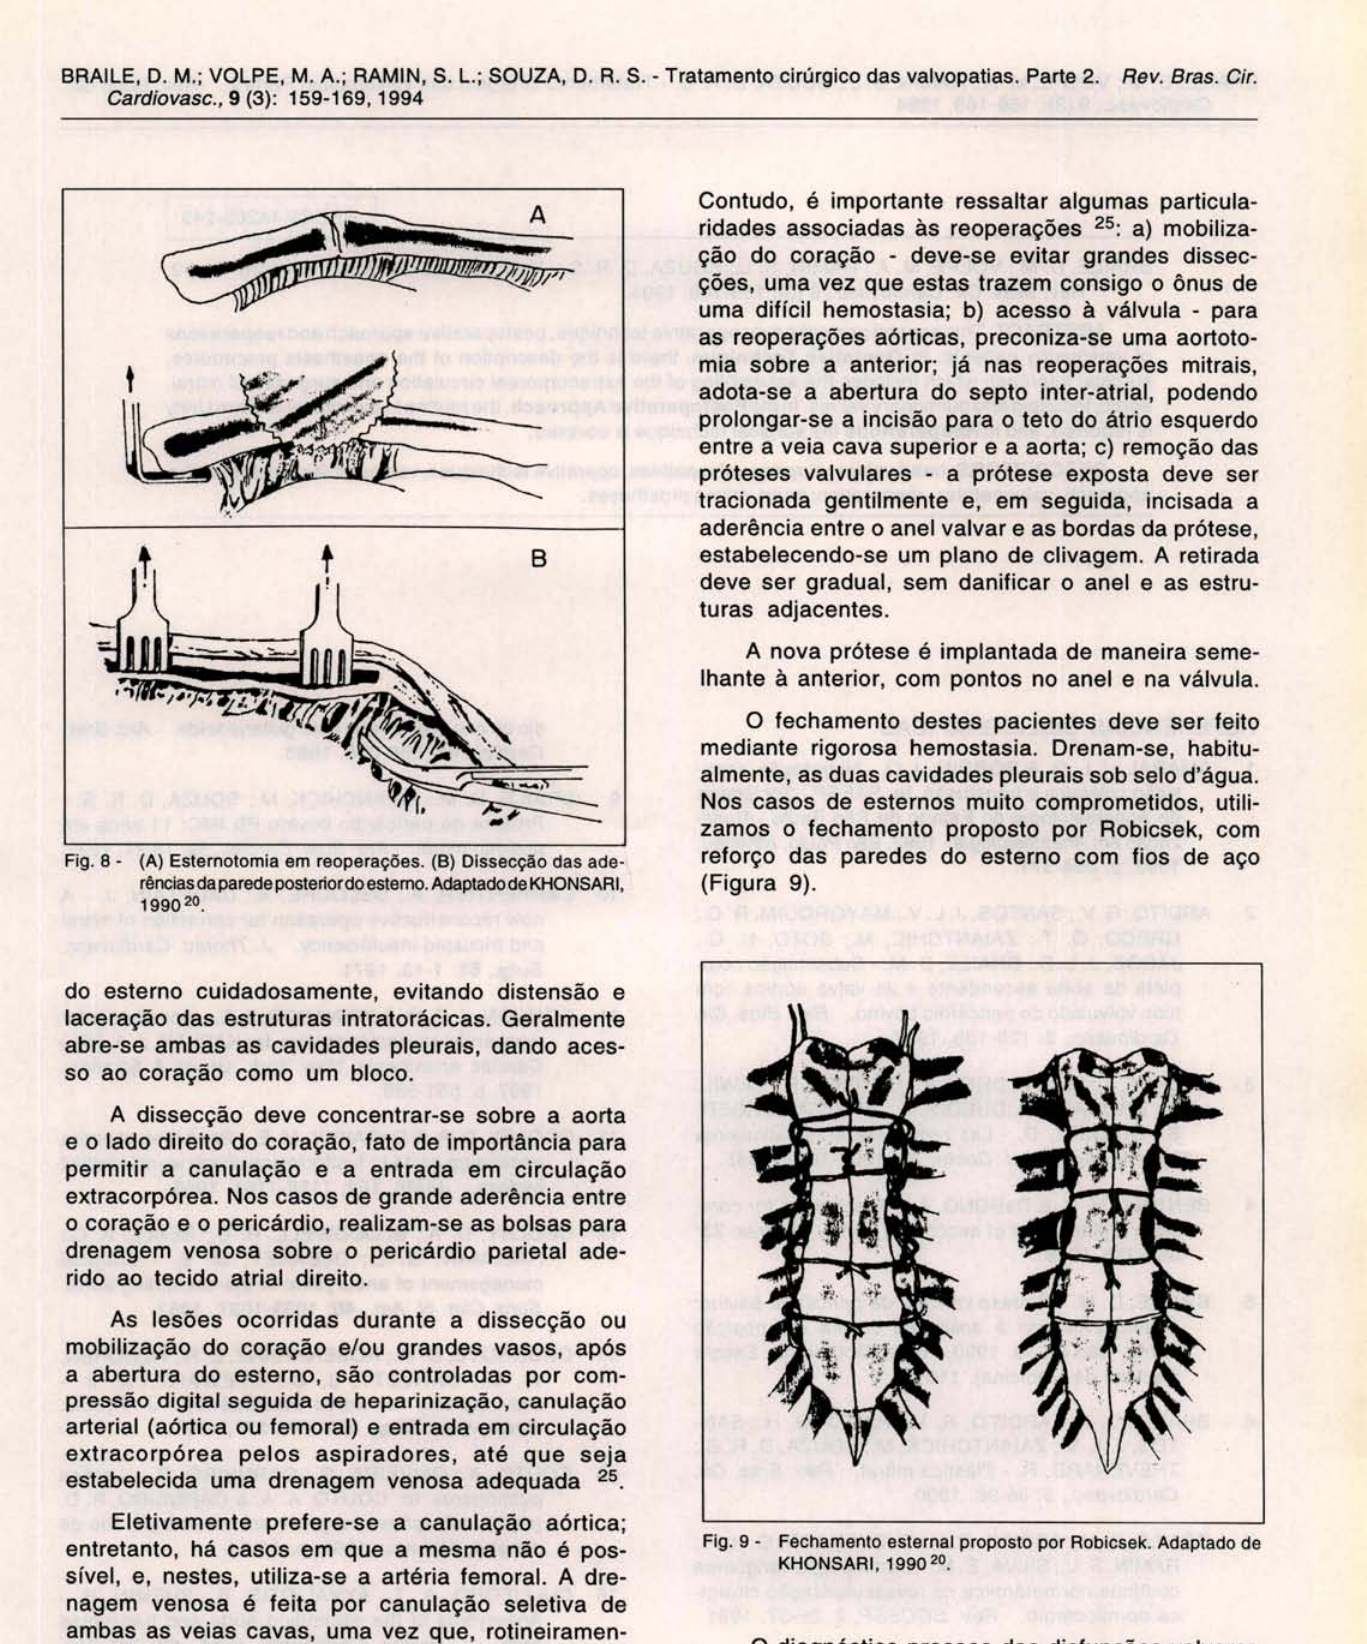
Fig. 9 - Fechamento esternal proposto por Robicsek. Adaptado de KHONSARI, 1990 2